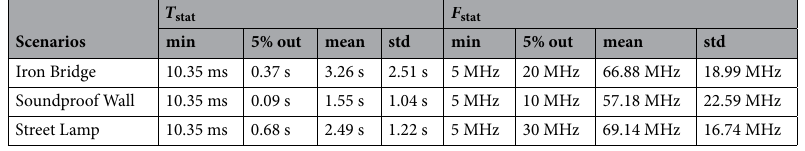
Table 2. Statistical results of the stationary time.